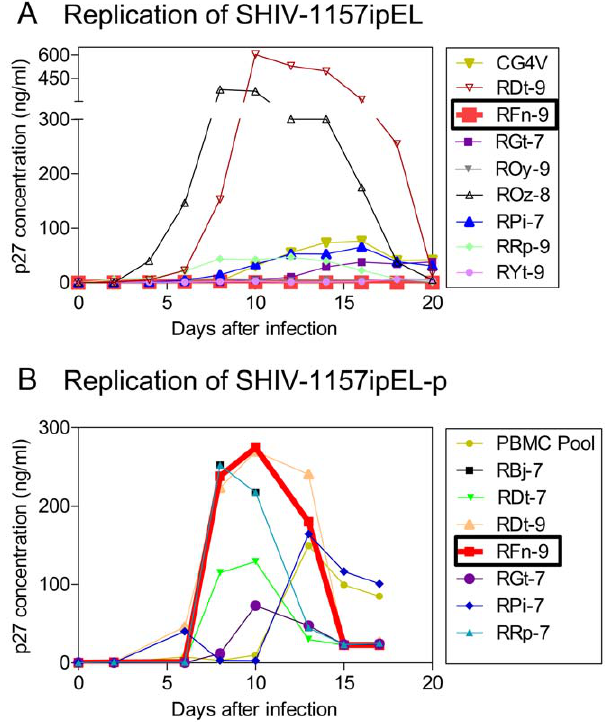
Figure 3. Replication of SHIV-1157ipEL and SHIV-1157ipEL-p in rhesus macaque PBMC. (A) PBMC from randomly selected naı¨ve RM donors were stimulated with concanavalin A (Con-A) and exposed to SHIV-1157ipEL-containing supernatant (Methods). The PBMC of RM RFn-9 (thick red line) did not support the replication of parental SHIV- 1157ipEL. (B) PBMC from random donors were stimulated with Con-A and exposed to passaged virus, SHIV-1157ipEL-p. Supernatants were harvested and p27 levels were measured at the time points indicated. PBMC cultures of RFn-9 (previously unable to support the replication of parental virus, see under A) now yielded high levels of p27 (thick red line), indicating SHIV-1157ipEL-p adaptation to RM. For RM listed in both A and B, aliquots of frozen PBMC from the same blood collection as in A were used for assays in B.